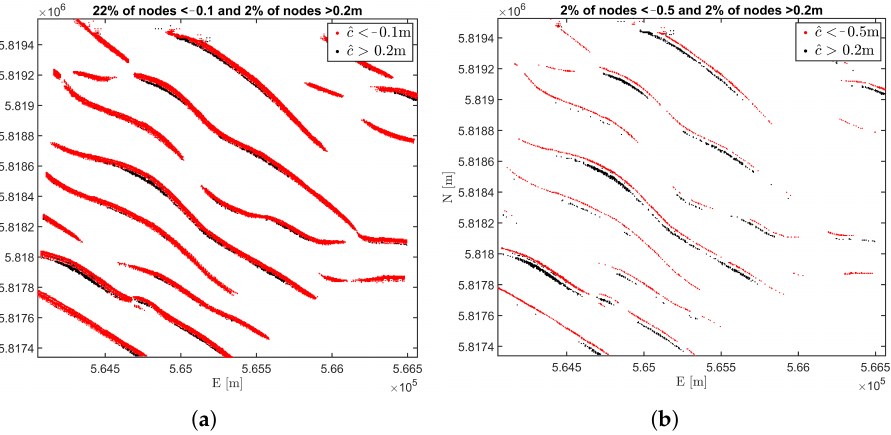
Figure 16. Vulnerable nodes at the 95% confidence interval for predefined decision thresholds. ( a ) presents the predicted probability at 95% confidence level using [0.2 m < ˆ c < − 0.1 m] and ( b ) Predicted probability at 95% confidence level using [0.2 m < ˆ c < − 0.5